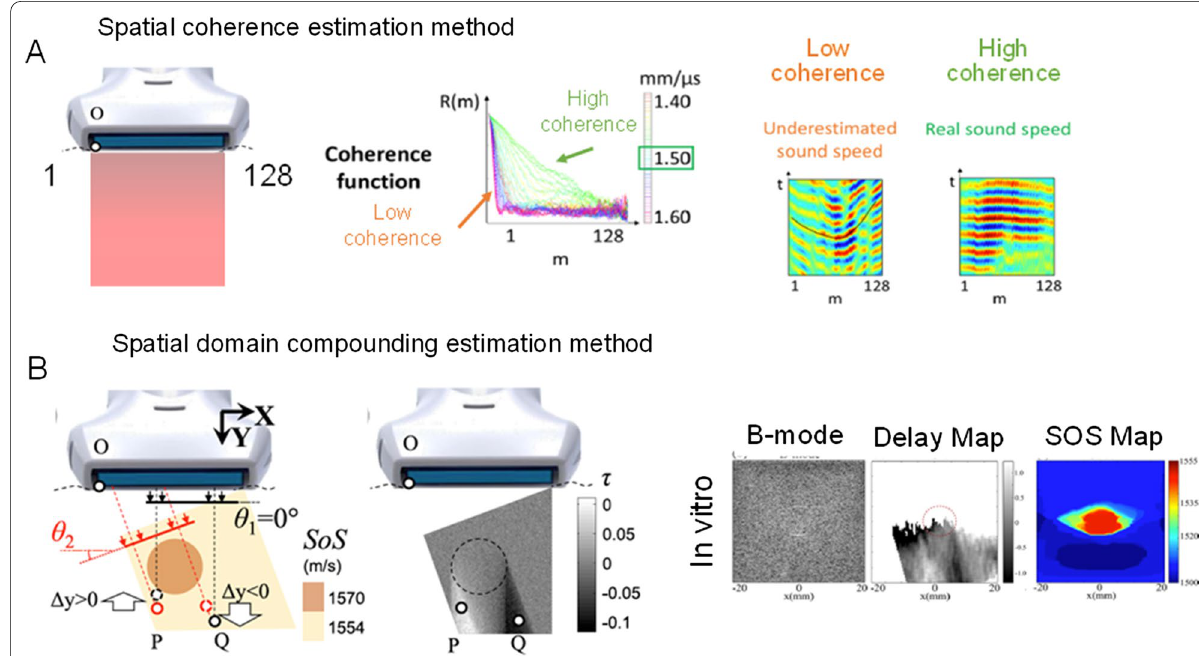
Fig. 9 Schematic representation of current local speed of sound (SoS) algorithms. a Local speed of sound assessed using the spatial coherence method provides a global value in m/s without a parametric image. A tissue with a low coherence R ( m ) among transducer elements location ( m 1–128 on this example) would underestimate the speed of sound, whereas a tissue with high coherence would provide the real speed of = sound. b Local speed of sound determined with the spatial domain compounding approach provides a parametric map of the speed of sound. Compounding is obtained by insonifying the tissue at different angles θ . See [37] for specific definitions of parameters used in this graph. Figure modified, adapted, and reproduced with permission from [36] and [37]